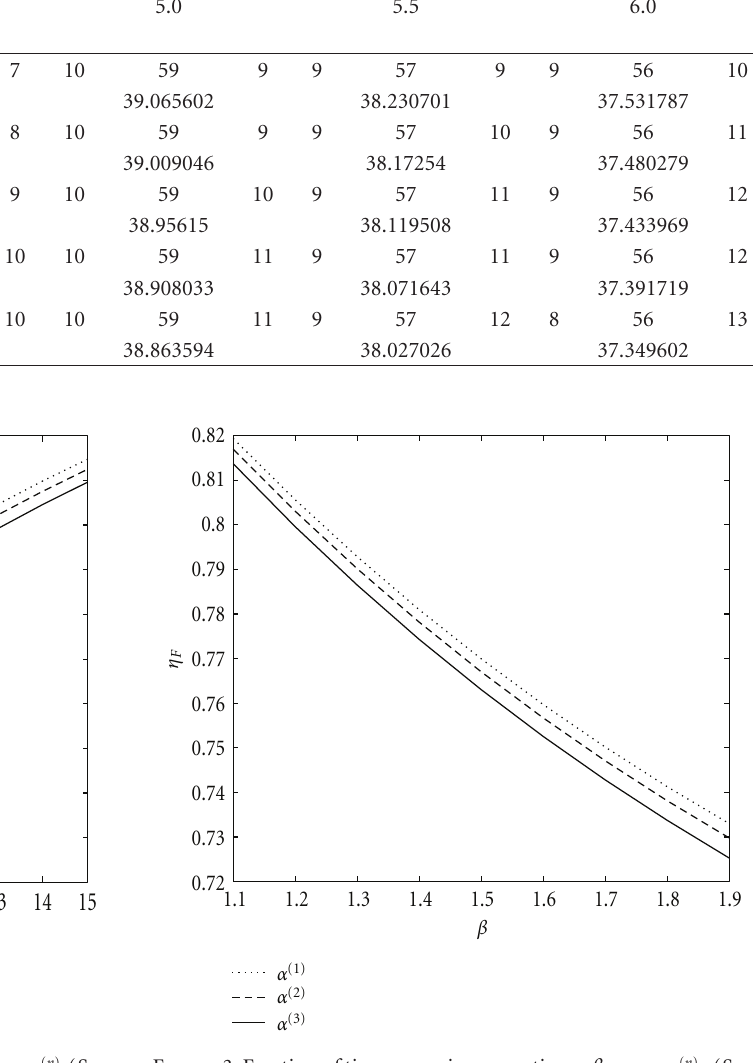
Figure 3: Fraction of time server is on vacation— β versus α ( n ) ( S = 90, s = 15, N = 25, λ = 8, γ = 4, μ = 0 . 8, p = 0 . 75 .